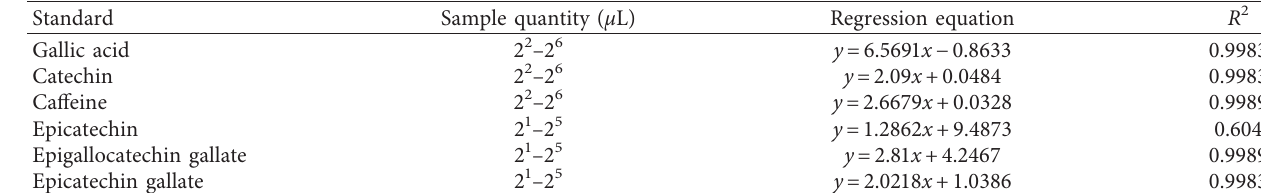
Table 1: Linear range of liquid chromatography in this